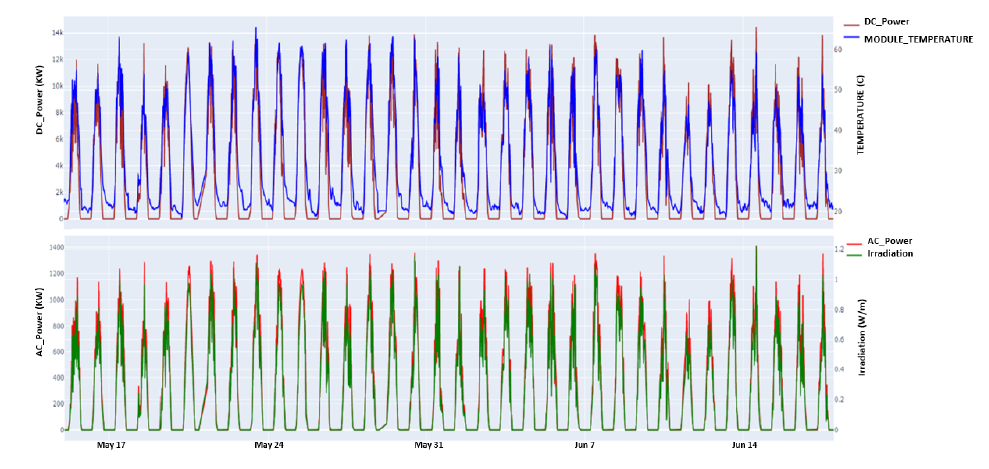
Figure 5. Signal comparison between AC, DC Power, Irradiation, and the Module Temperature signals from inverter number